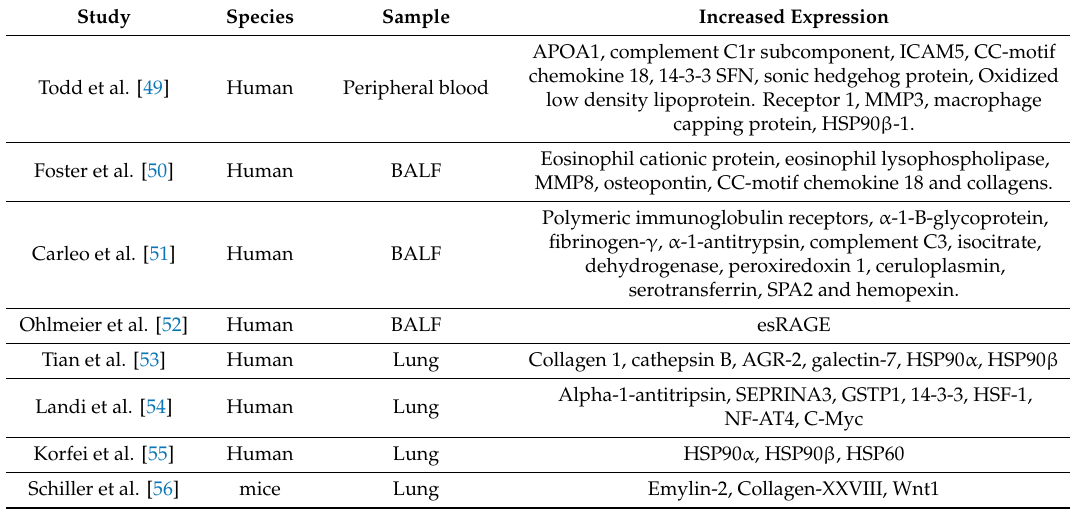
Table 1. Proteomic analysis in studies on Idiopathic Pulmonary Fibrosis